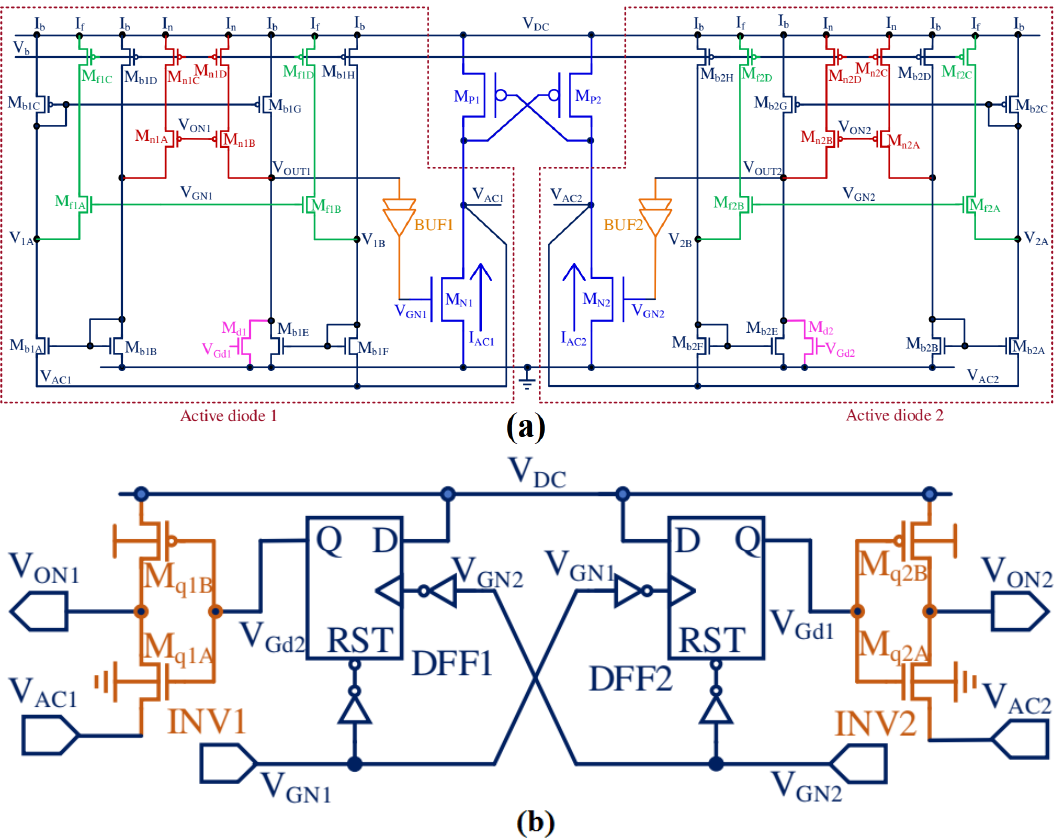
Figure 23. ( a ) Circuit implementation of digitally controlled on-off delay compensated full-wave rectifier and ( b ) control logic present in [51]. Reproduced with permission from S- Pal, IEEE Transactions on Circuits and System II: Express Briefs; published by IEEE,